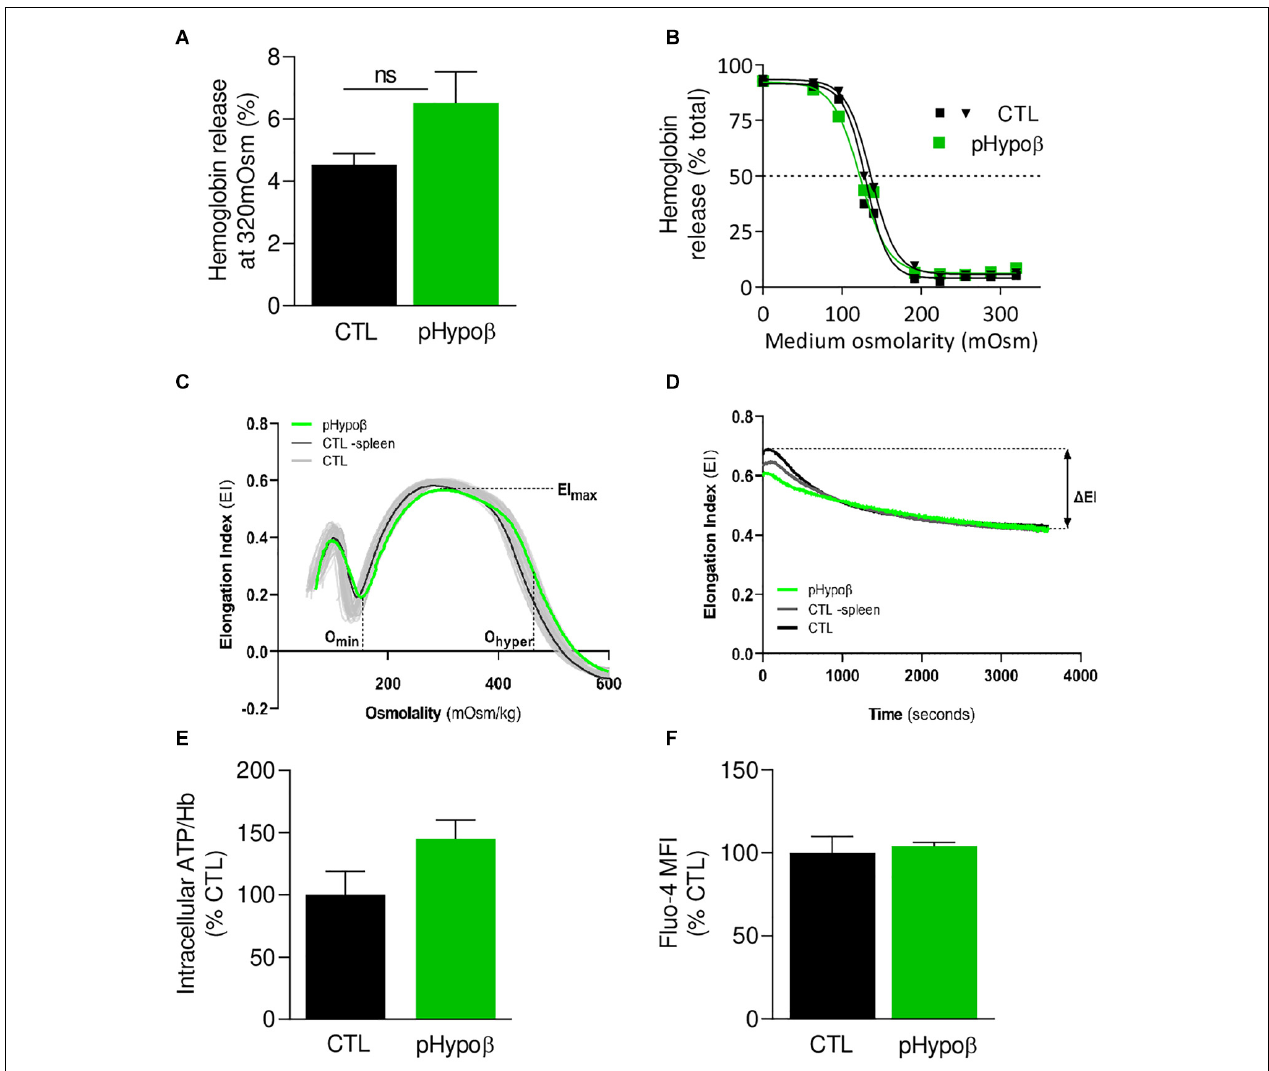
FIGURE 2 | The extent of hemoglobin release and the intracellular calcium and ATP levels are preserved in pHypo β RBCs while deformability upon shear stress is slightly decreased. RBCs from healthy donors (black and gray in panel C ) or pHypo β (green) were evaluated for osmotic fragility (A,B) , deformability (C,D) , intracellular ATP (E) and calcium content (F) . (A,B) RBC osmotic fragility. RBCs were incubated in isotonic (A) or increasingly hypotonic (B) media and then centrifugated. Hemoglobin (Hb) in supernatants and in RBC pellets was assessed spectrophotometrically to determine hemolysis. The horizontal dotted line in (B) indicates the medium osmolarity at which 50% of the RBCs were lysed. Data are means ± SEM of 4 independent experiments for (A) and are representative for 2 independent experiments in (B) . Mann–Whitney test; ns, not significant. (C,D) RBC deformability. (C) Osmotic gradient ektacytometry curve and derived EI max , O min , and O hyper parameters, which, respectively, reflect membrane surface area, surface area-to-volume ratio and cellular hydration. pHypo β RBCs (green curve) were compared to healthy controls (gray curves obtained from 25 healthy subjects) and a healthy splenectomized control (black curve). (D) Cell membrane stability test (CMST) curve and the derived (cid:49) EI parameter which depicts the capacity of the RBCs to shed membrane and resist shear stress. Data are representative of 2 experiments in (C) and 1 experiment in (D) . (E) Intracellular ATP. ATP levels were determined with a kit based on the activity of the firefly luciferase in presence of ATP and the consequent light emission in presence of luciferin. Intracellular ATP levels were normalized to Hb and expressed as percentage of the CTL RBCs. Data are means ± SD of triplicates from 1 experiment. (F) RBC calcium content. RBCs were labeled with the non-fluorescent Fluo4-AM which is transformed in RBCs into the fluorescent Fluo4 after de-esterification and interaction with calcium ions. Labeled RBCs were analyzed by flow cytometry for median fluorescence intensity (MFI) and then expressed as percentage of CTLs. Data are means ± SD of triplicates from 1